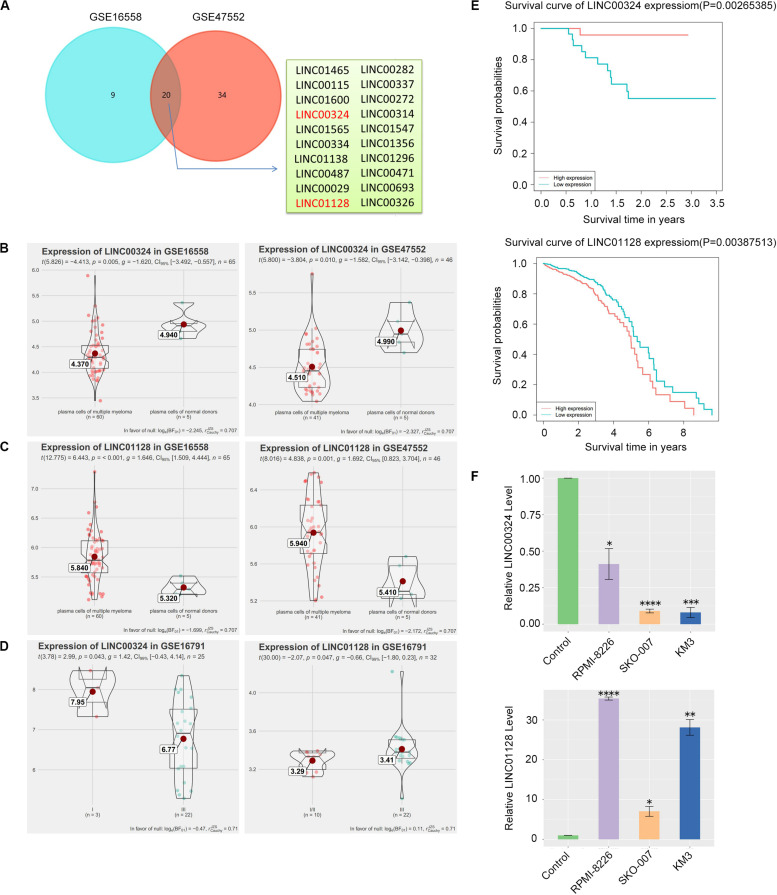
Detection and validation of differentially expressed lncRNAs (DELs). (A) Venn plot of DELs between GSE16558 and GSE47552. (B) GSE16558 and GSE47552 indicated the lower expression of LINC00324 in CD138+ plasma cells of MM patients compared with normal donors. (C) GSE16558 and GSE47552 indicated the higher expression of LINC01128 in CD138+ plasma cells of MM patients compared with normal donors. (D) Relationship between the two lncRNAs and cancer stages in GSE16791. (E) GSE57317 dataset (left) and TCCA dataset (right) revealed that MM patients with low expression of LINC00324 and high expression of LINC01128 had an obviously poorer overall survival. (F) Expression of LINC00324 (top) and LINC01128 (bottom) in human multiple myeloma cell lines (RPMI-8226, SKO-007, KM3) as well as normal plasma cells. Data are presented as the mean ± standard deviation. *P < 0.05, **P < 0.01, ***P < 0.001, ****P < 0.0001.